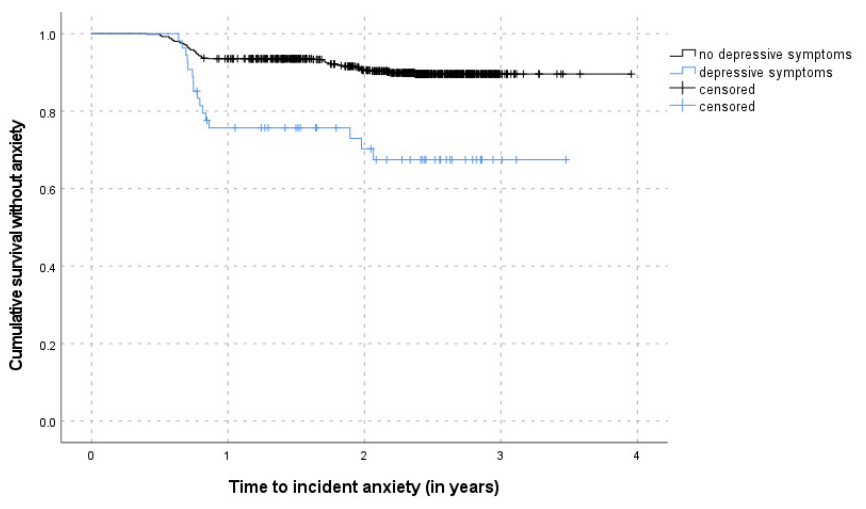
Figure 2. Kaplan–Meier survival curves according to depressive symptoms.